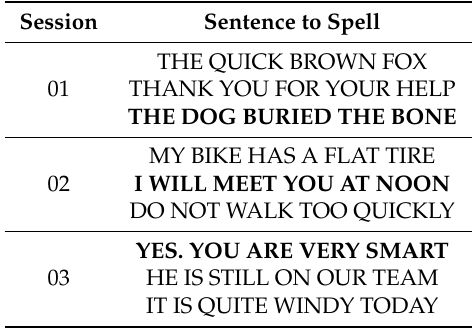
Figure 1. Visual interface of the 6 × 6 matrix used in this study. A row or column intensified for 67 ms, followed by a 100 ms pause. The front-most image shows an intensification of the column containing the character “T”. This is the current target, so a P300 is expected to be elicited by this intensification. Table 1. Sentences copied by the